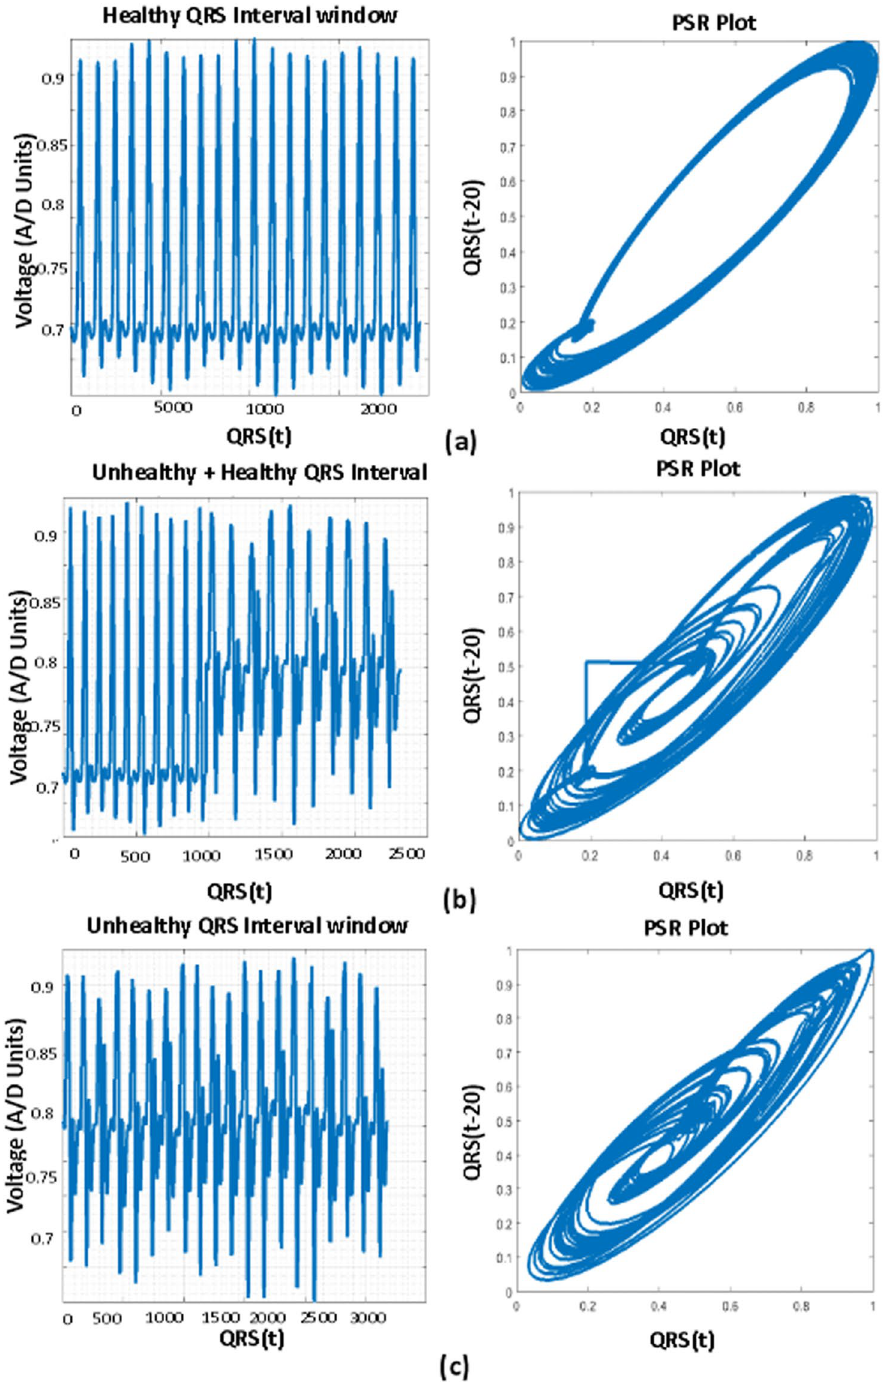
Figure 18. PSR plots of the window covering QRS complexes. ( a ) Healthy QRS complexes and its PSR plot. ( b ) Combination of healthy and unhealthy QRS complexes. ( c ) Unhealthy QRS complexes and its PSR